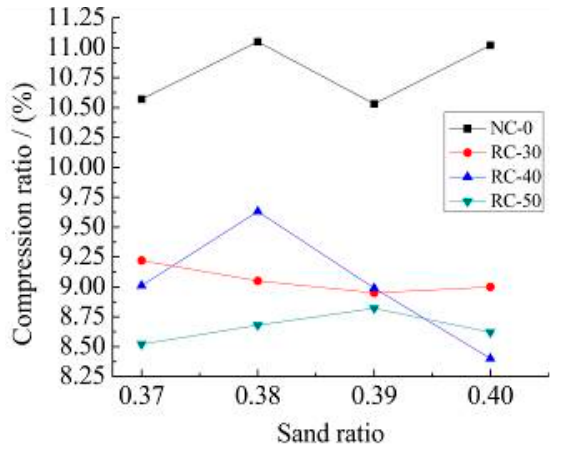
Figure 11. Bend and compression